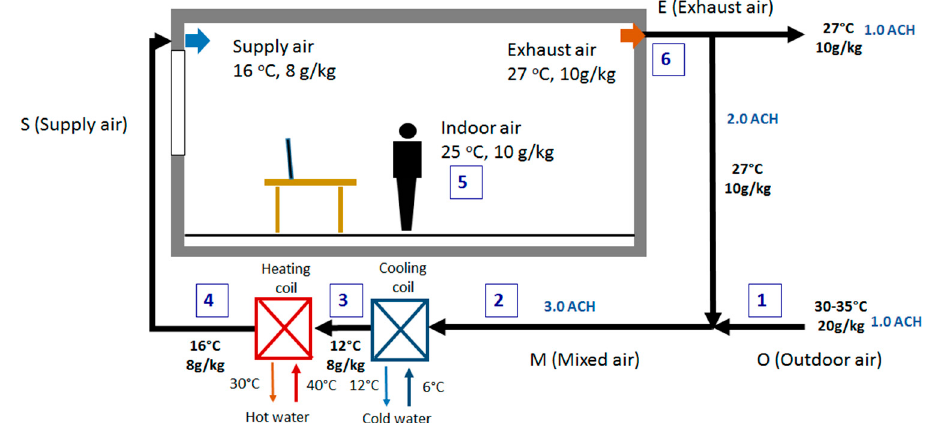
Figure 1. Schematic of the AAS for the cooling, dehumidification, and reheating processes. A CRCS with an AHU consumes less energy than an AAS [30] because it minimizes the air volume supplied, and the high-temperature cooling system can minimize entropy generation and maximize the coefficient of performance ( COP ). The system is divided into the air ventilation and cooling tasks by employing radiant cooling panels to deal with the sensible cooling load while utilizing a fresh air supplying system [31,32]. Figure 2 illustrates a schematic of the CRCS with AHU. However, this system has limitations for use in certain places. High internal humidity gains cause moisture condensation on the chilled radiant panel surface. Therefore, the supply air should be dehumidified below 8 g/kg of the humidity ratio in case of internal humidity gains [33,34]. Compared with an AAS, a CRCS has a time delay for activation when cooling in a room [35–37]. Small airflow rates have difficulty improving indoor air quality in a highly polluted zone [30,38,39]. The CRCS also has difficulties adjusting the cooling outcome because a chilled water supply directly passing through the radiant cooling panel causes condensation, especially in hot and humid surrounding conditions [32,40–42]. Most buildings in China use the AAS because China weather conditions are hot and humid in the summer season, and the CRCS is limited to use in a building that combines natural ventilation system and a high infiltration rate with poor air tightness. However, the AAS has been widely used in residential and commercial buildings since it can simply adjust cooling outputs with a variable air volume control system.